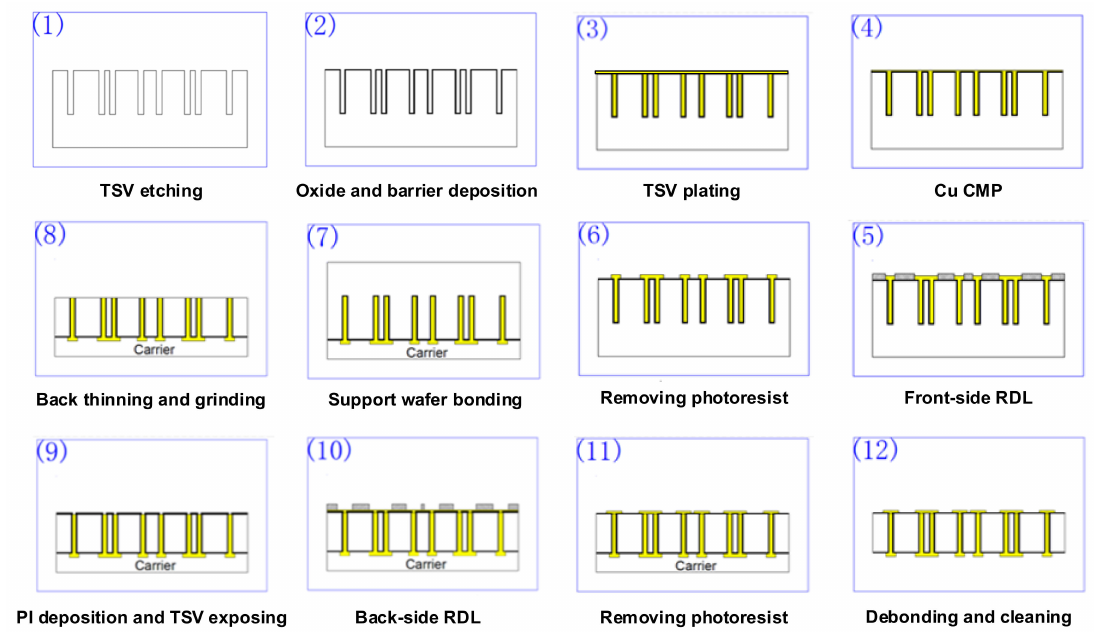
Figure 3. Process flow of the bottom HR-Si interposer